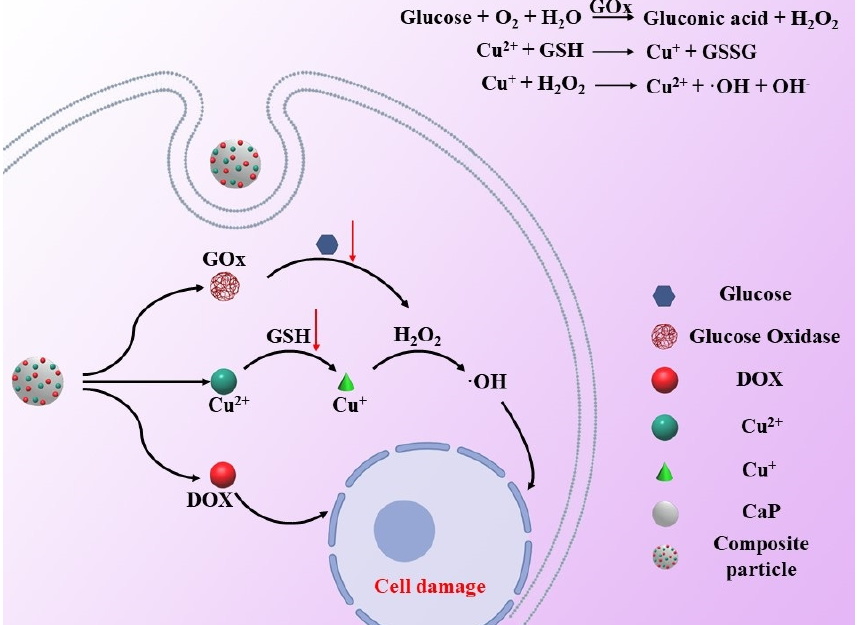
Figure 6. Schematic illustration of Cu + —induced antitumor therapy. The released Cu 2+ with the degradation of calcium phosphate in tumor cells can react with glutathione to form the Fenton agent Cu + , which further triggers the H 2 O 2 to generate ⋅ OH to enhance the antitumor effect.